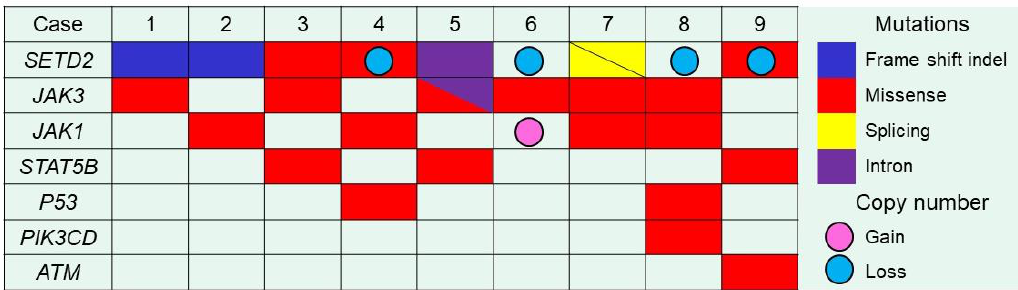
Figure 1. Mutations of SETD2 , genes of JAK/STAT pathway and others. The mutational landscape of Japanese MEITL was analyzed targeting 26 genes and our previous array CGH data was included in the analysis as well. Biallelic or double mutations are represented as triangles and single mutations as full colored squares. Colored circles indicate copy-number changes.